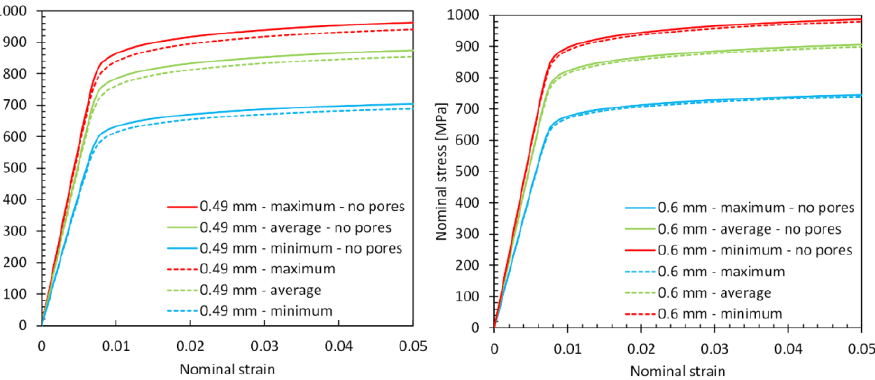
Figure 12. Nominal stress – strain curves obtained for 0.49 mm (on the left) and 0.6 mm (on the right) strut diameters under tension with a nominal strain of up to 0.05.